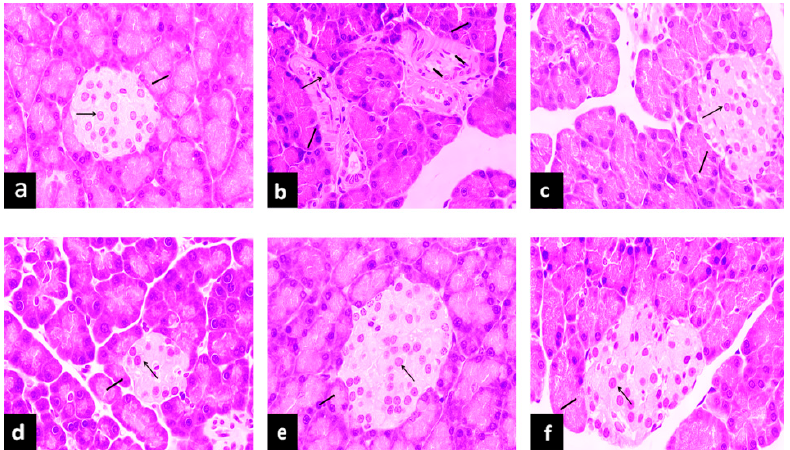
Figure 6. Effects of purified anthraquinone-Glycoside from Rheum palmatum L. (PAGR) on histopathological changes in the pancreas of rats. Histological observation, H&E, a–f×400;( a ), normal (NC) group; ( b ), type 2 diabetes mellitus (T2DM) group; ( c ), metformin (Met) group; ( d ), Low group;